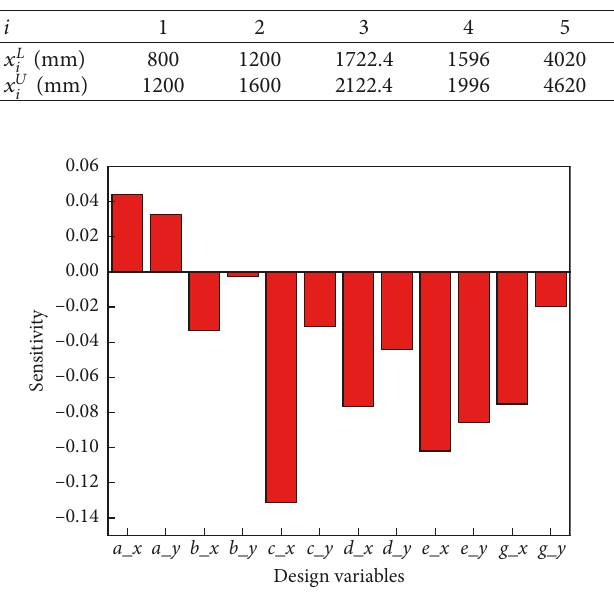
Table 5: The upper and lower bounds of design variables (mm).